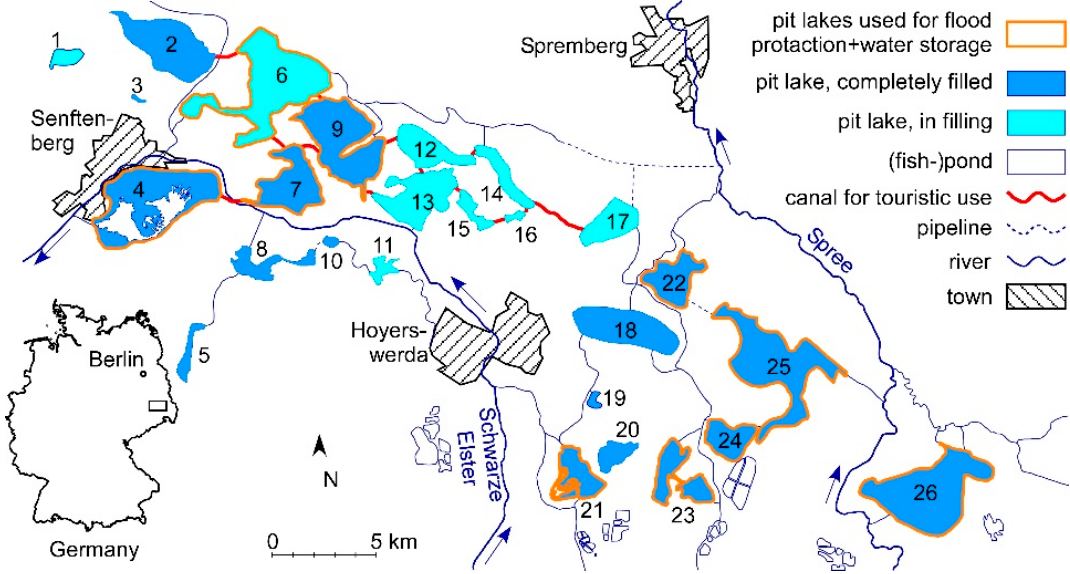
Figure 7. Pit lakes of the central part of the Lusatian Lignite Mining District (Germany). Pit lakes marked by orange lines are used for flood protection and water storage. Canals and water gates connecting pit lakes for touristic use are indicated by red